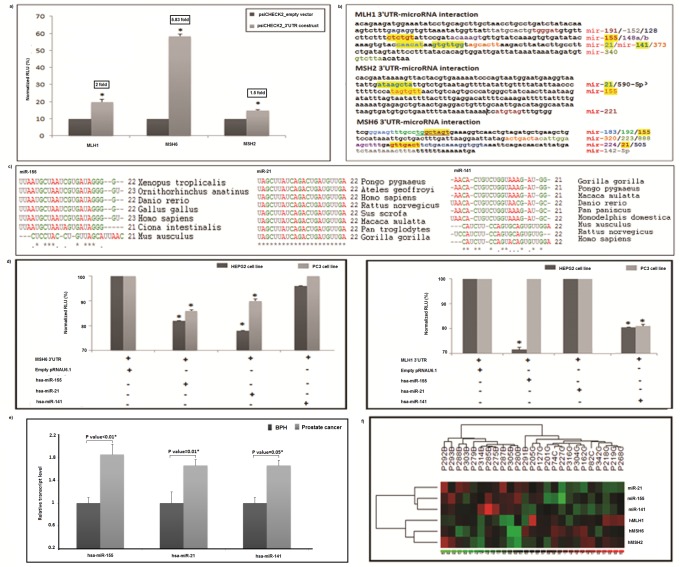
Interaction of MMR gene 3'UTRs with microRNAs.(a) Bar diagram illustrating positive 3'UTR activity of hMLH1, hMSH6 and hMSH2 genes in HEPG2 cells following reporter gene assay. Fold changes were appended in the diagram. (*) indicates statistical significance of functionality of 3'UTR regions measured in terms of P value by t-test. (b) Entire 3'UTR region of hMLH1, hMSH2 and hMSH6 were mapped for putative microRNA binding sites. The highlighted and boldfaced segments within the 3'UTR sequences represent the seed positions for the microRNAs. (c) Multiple alignments indicated that miR-155, miR-21 and miR-141 seed sequences are evolutionarily conserved across mammalian and non-mammalian species. (d) Normalized relative light units (RLU) in HEPG2 and PC3 cells were measured for hMLH1 and hMSH6 3'-UTR constructs in pSiCHECK2 with (+) and without (-) the effect of microRNAs. Co-transfection of the pRNAU6.1 empty vector (+) with the 3'UTR-pSiCHECK2 constructs of hMLH1 and hMSH6 were set as 100% and percentage reduction in luciferase activity mediated by the three microRNAs were measured in relation to this was shown in the bar diagram. Statistical significance in terms of P values was measured with t-test. (*) indicates the statistical significance P<0.05. (e) Bar diagram showing upregulation of hsa-miR-21, hsa-miR-155 and hsa-miR-141transcripts in prostate cancer tissues compared to that of BPH patients. * indicates P<0.05. (f) Heat map showing the combination of two dendrograms displayed above and to the right. The rows represent genes on the right of the figure. Individual patient sample is shown as columns. Color represents expression level of the gene. Red represents low expression, while green represents high expression. The expression levels are continuously mapped on the color scale provided at the bottom of the figure. The dendrograms show stratification of samples into two groups: BPH (B) and prostate cancer (P), based on gene expression.